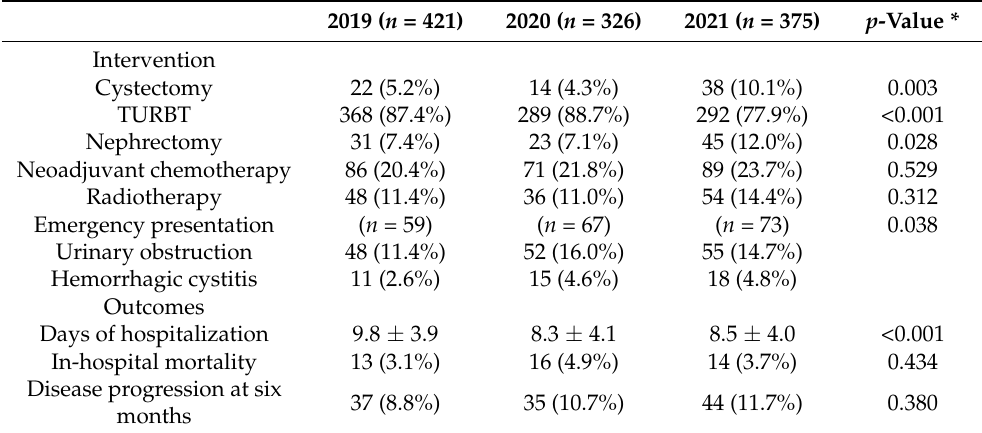
Table 3. Comparison of urothelial cancer management during the study period.